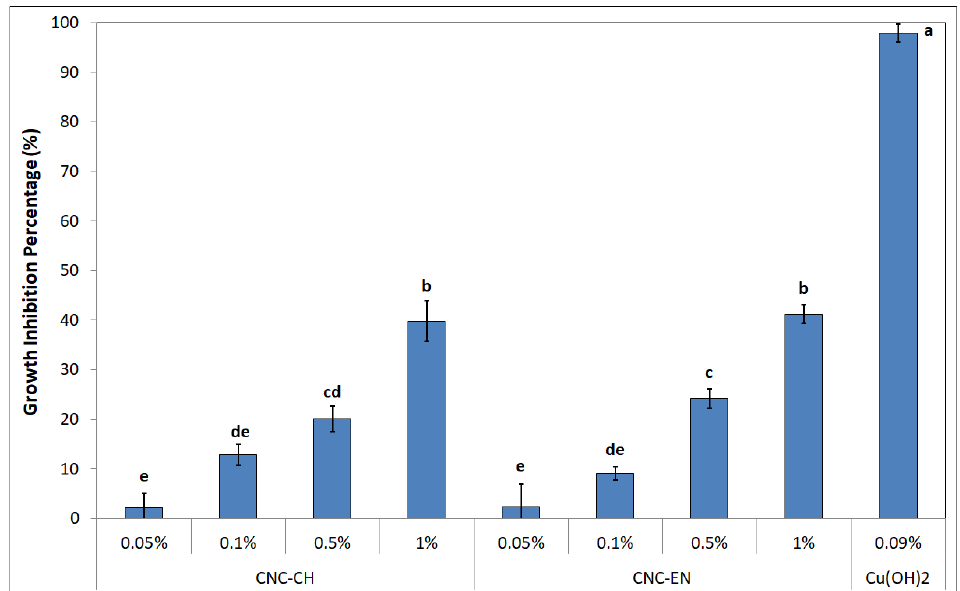
Figure 7. Growth inhibition percentage showed by CNC-CH and CNC-EN on Pto after 24 h. Data represent the mean and standard deviation; different letters show significantly different values after one-way ANOVA, followed by Tukey’s HSD post hoc test ( p < 0.05 ).